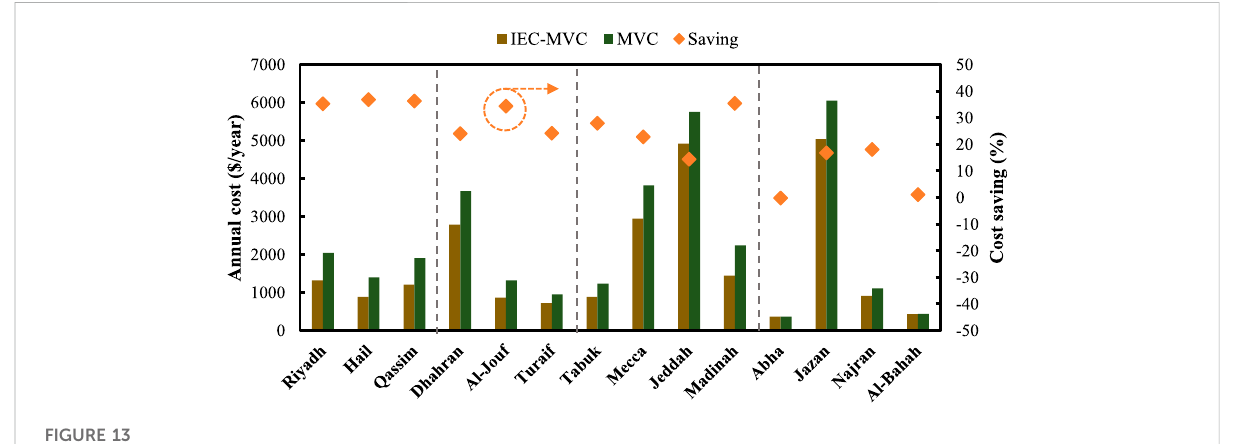
FIGURE 13 Comparison of annual cost between IEC-MVC and standalone